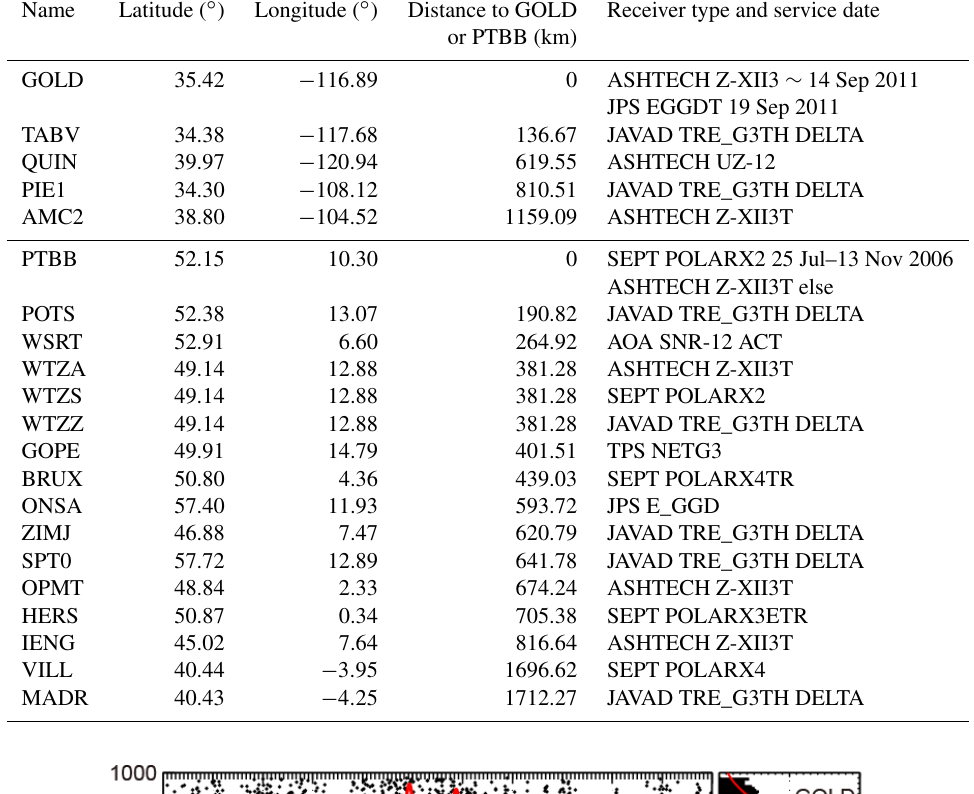
Table 1. Information for the stations.